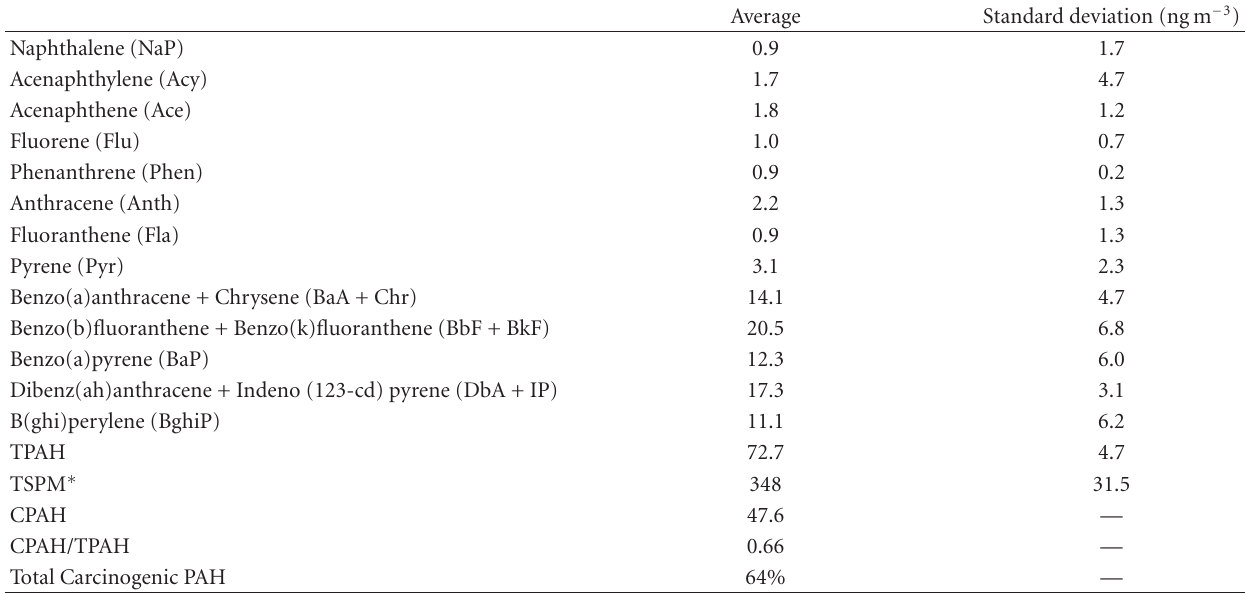
Table 1: Mean and standard deviations for all PAHs (ngm − 3